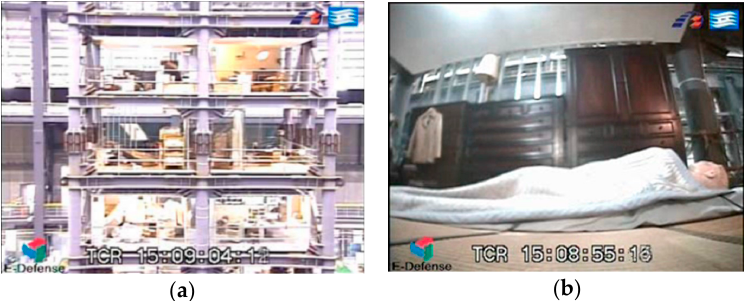
Figure 6. Shaking table test of indoor movable furniture, ( a ) full-scale 5-story shaking table test; ( b ) indoor scene on the third story. ( b ) indoor scene on the third story.